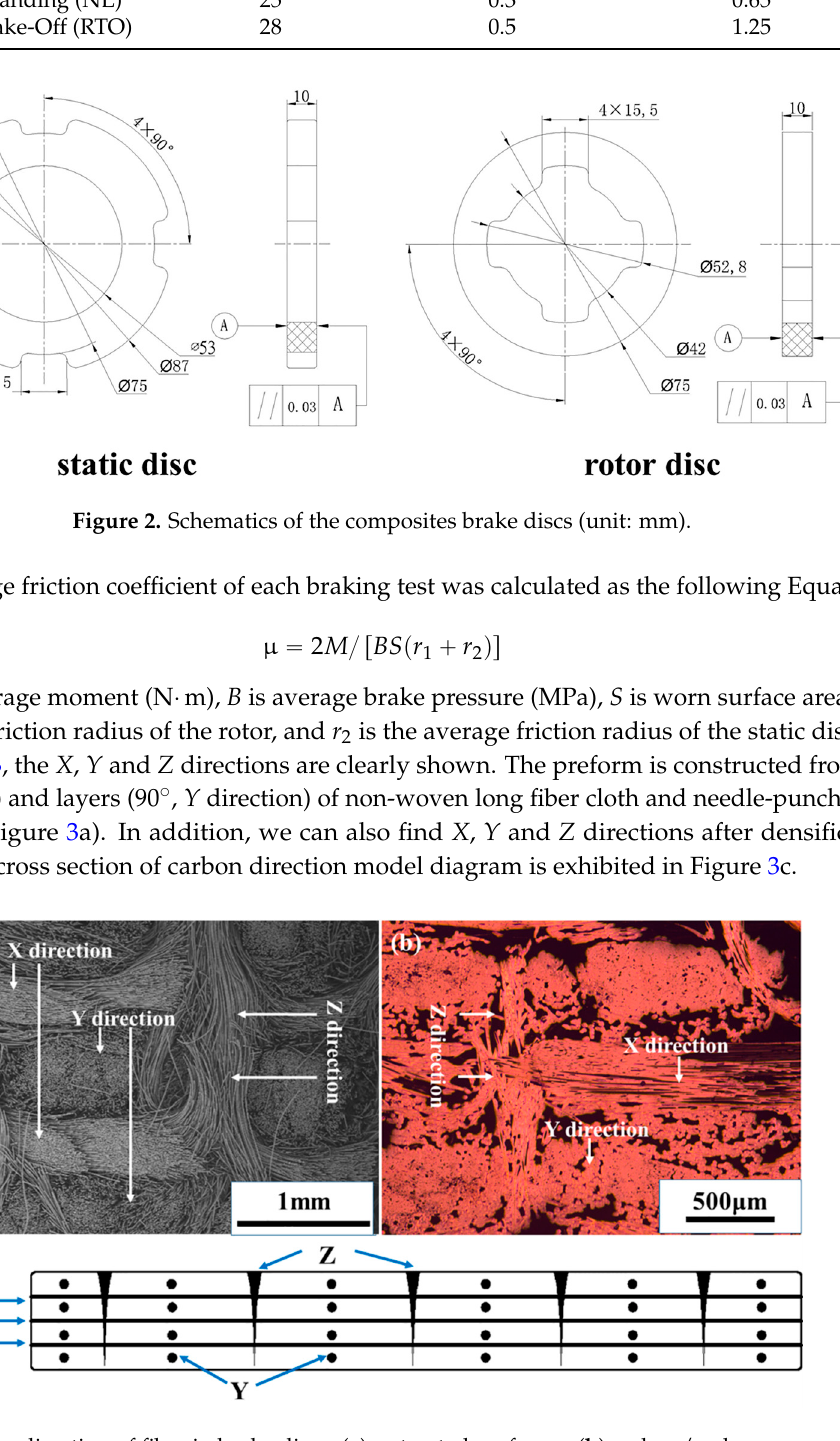
Figure 3. The direction of fiber in brake discs: ( a ) untreated preforms; ( b ) carbon/carbon composites; ( c ) schematic cross section.